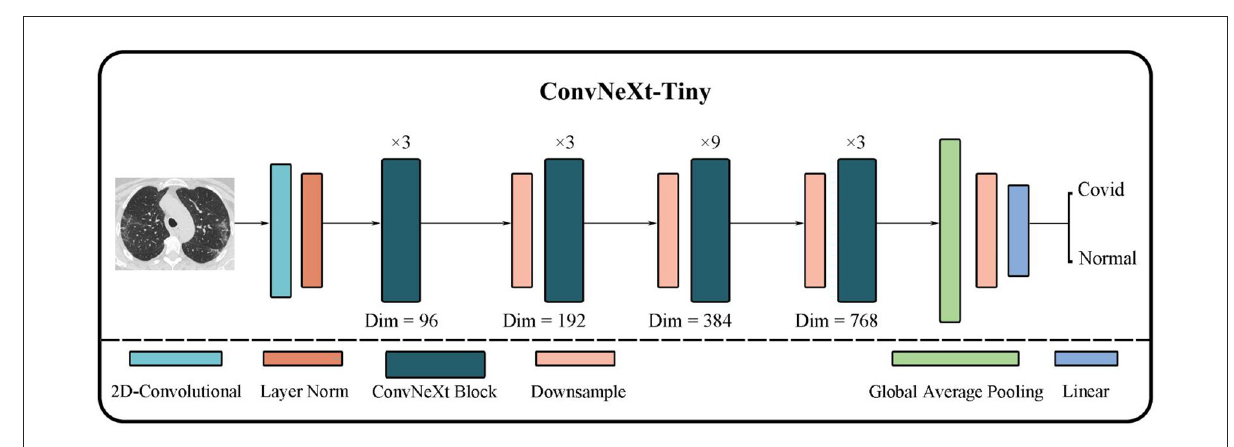
FIGURE4 Concise structure of